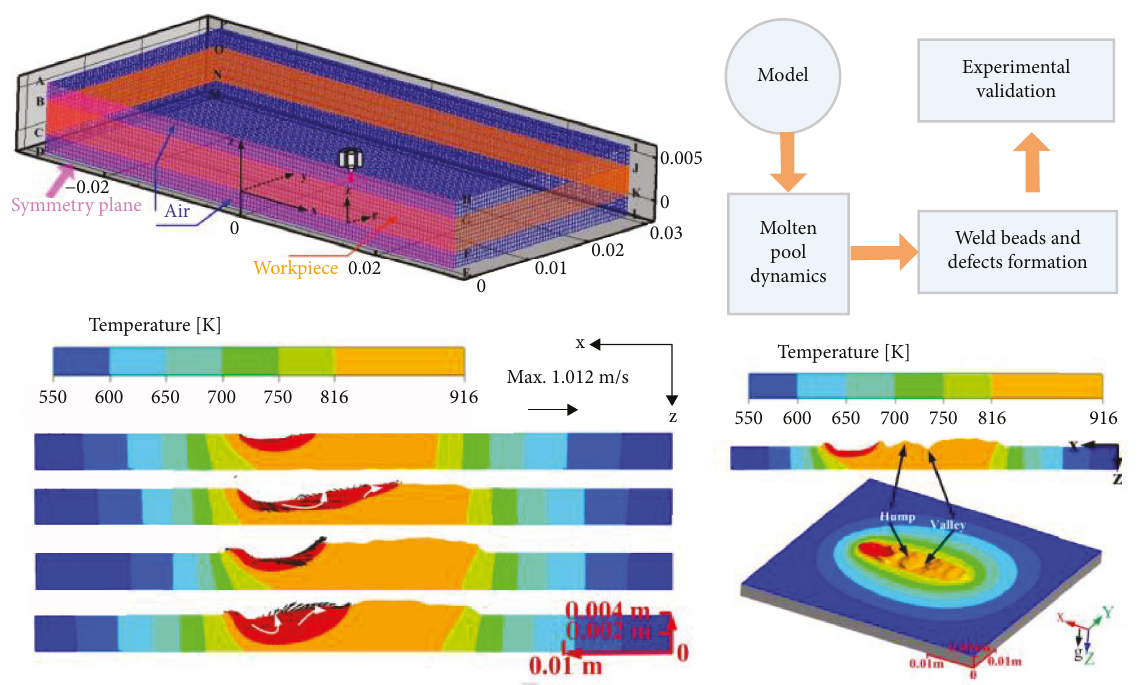
Figure 12: Simulation results of Pan et